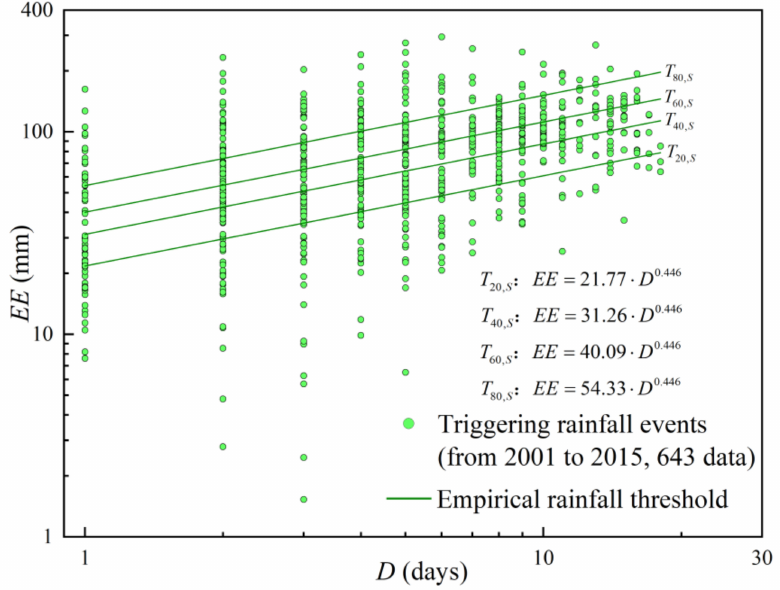
Figure 9. EE-D empirical rainfall threshold at 20% ( T 20,S ), 40% ( T 40,S ), 60% ( T 60,S ), and 80% ( T 80,S ) exceedance probability